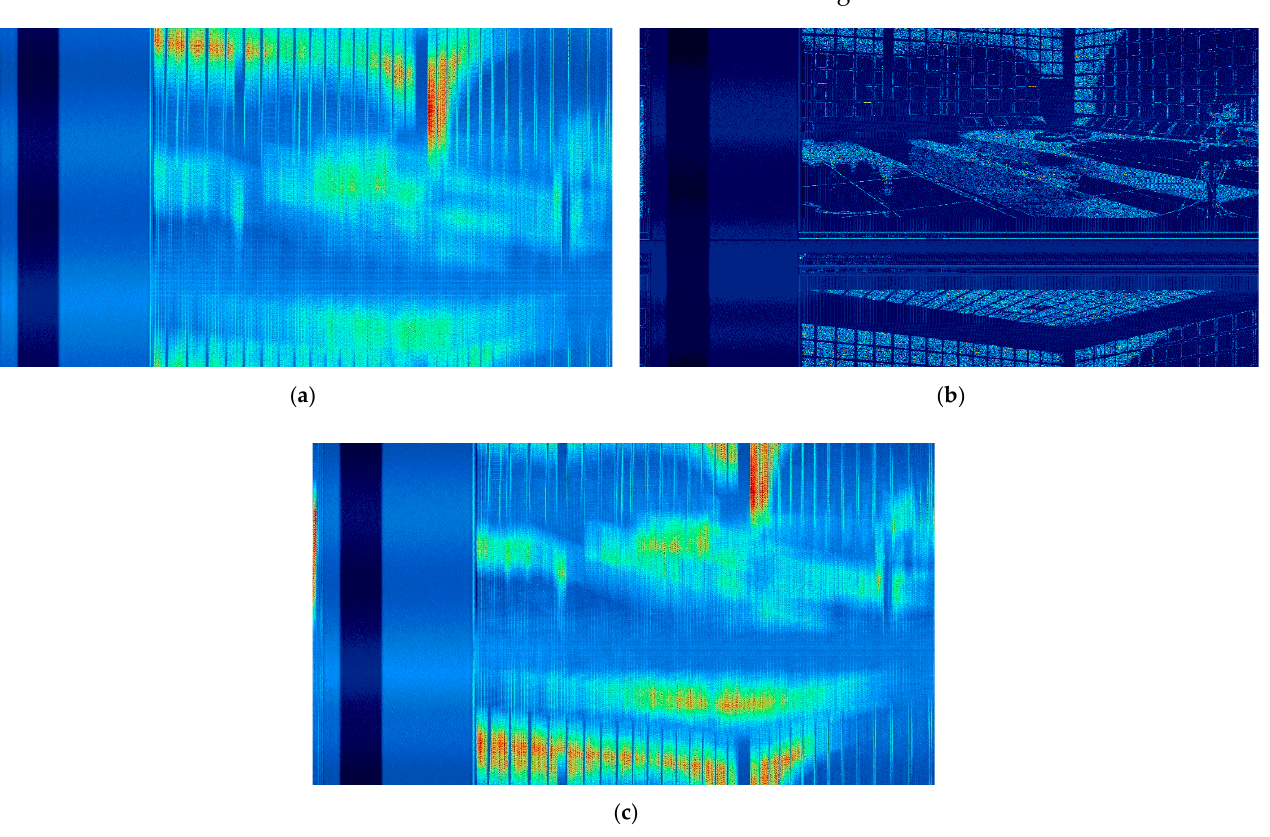
( b ) Figure 5. Illustrating the influence of a wrongly determined number lines of image on the result of coherent summation (a summation of two first images): ( a ) for a small number lines of image, ( b ) for a large number lines of image. One of the measures used in the assessment of image quality is the one related to the contrast of the analysed image [33]. We can mention here the measures based directly on the values of the maximum and minimum pixel amplitudes, the values of the average pixel amplitudes or the variance of the pixel amplitudes. The fulfilment of the appropriate criterion, i.e., the maximum value of these measures, clearly indicates the correct number B of the line for which the appropriate values are calculated [28]. It should be noted, how- ever, that the change in the number of B lines does not change the amplitudes of the pixels composing the image in the case of measures related to the contrast assessment. It only increases the number of pixels that are included in the calculation of each measure. Thus, it does not change the image quality and the contrast assessment. Hence, direct use of the measure of image contrast becomes ineffective. It also indicates the necessity to: •